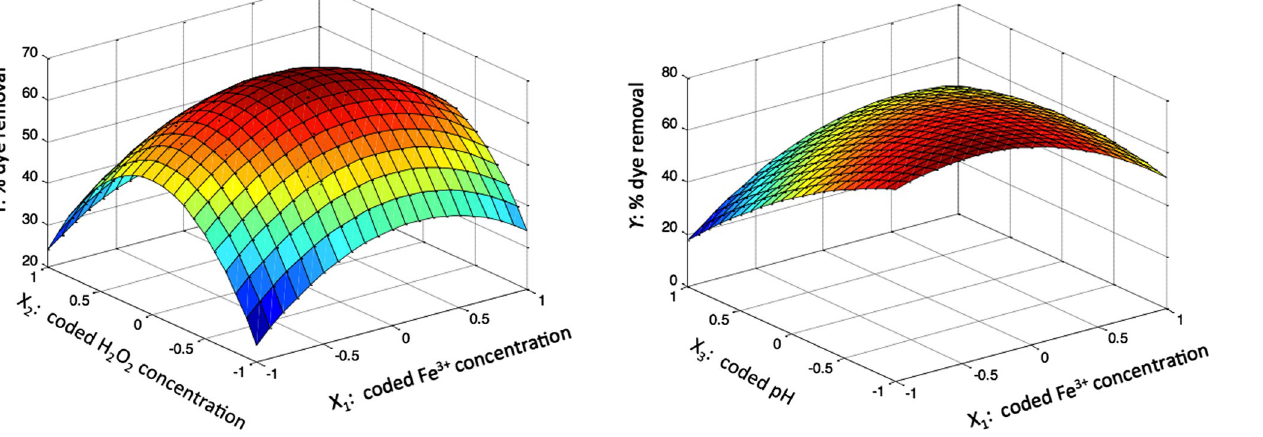
Fig. 5 Surface graph of dye removal showing interaction of Fe 3+ dos- age and pH